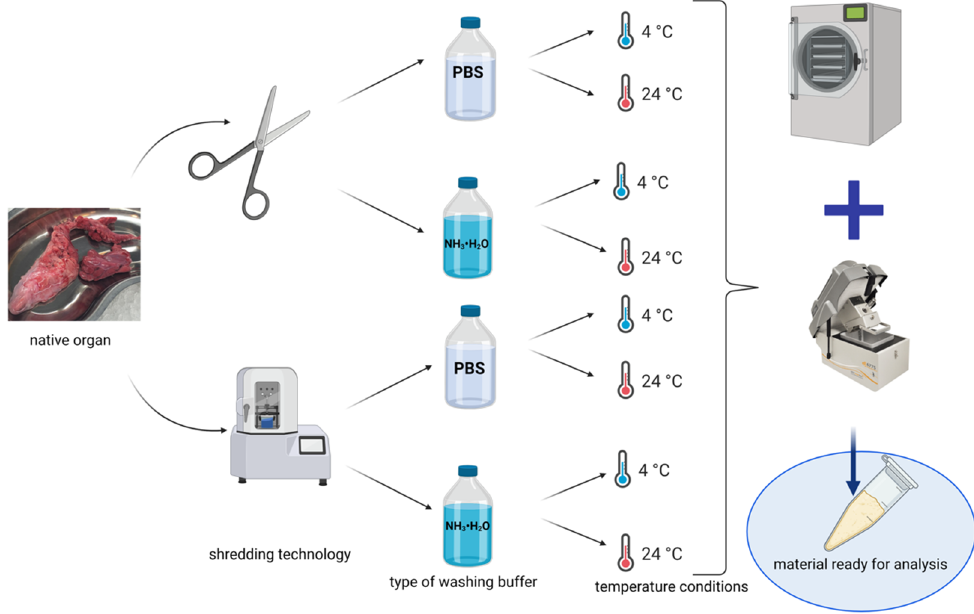
Figure 12. Experiment scheme including method of preparation of biological material. Created in BioRender.com, accessed on 27 June 2021.